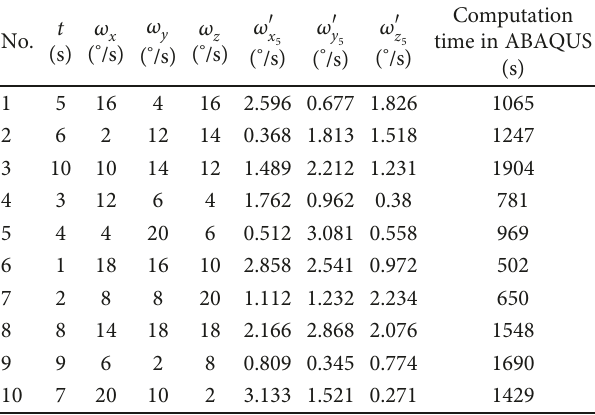
Table 18: Simulation results of empty storage tank and microsatellite with the deployment mechanism.